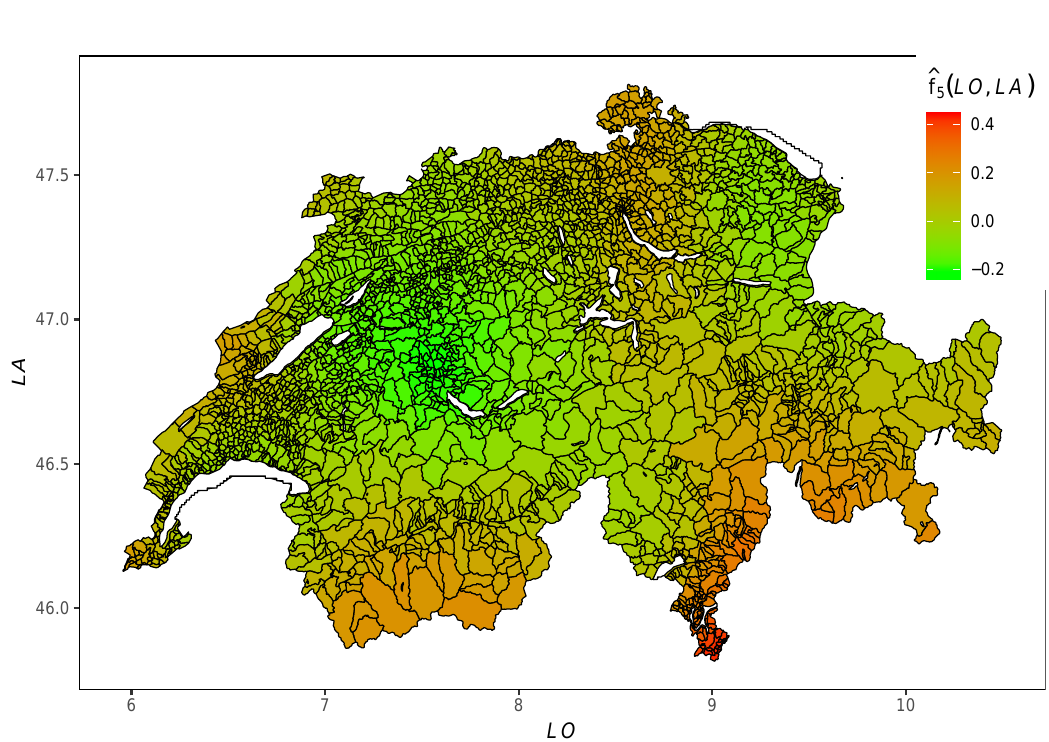
Figure 3. Illustration of the spatial GAM effect ˆ f 5 ( LO , LA ) along longitude and